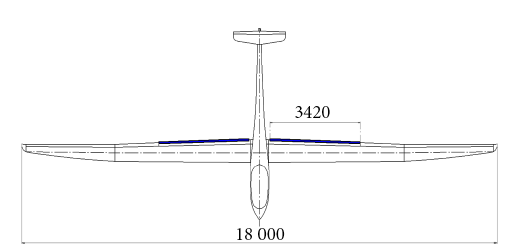
Fig. 15. The VGMF in sailplane LAK-17B (Figure: K-E. Seegel)